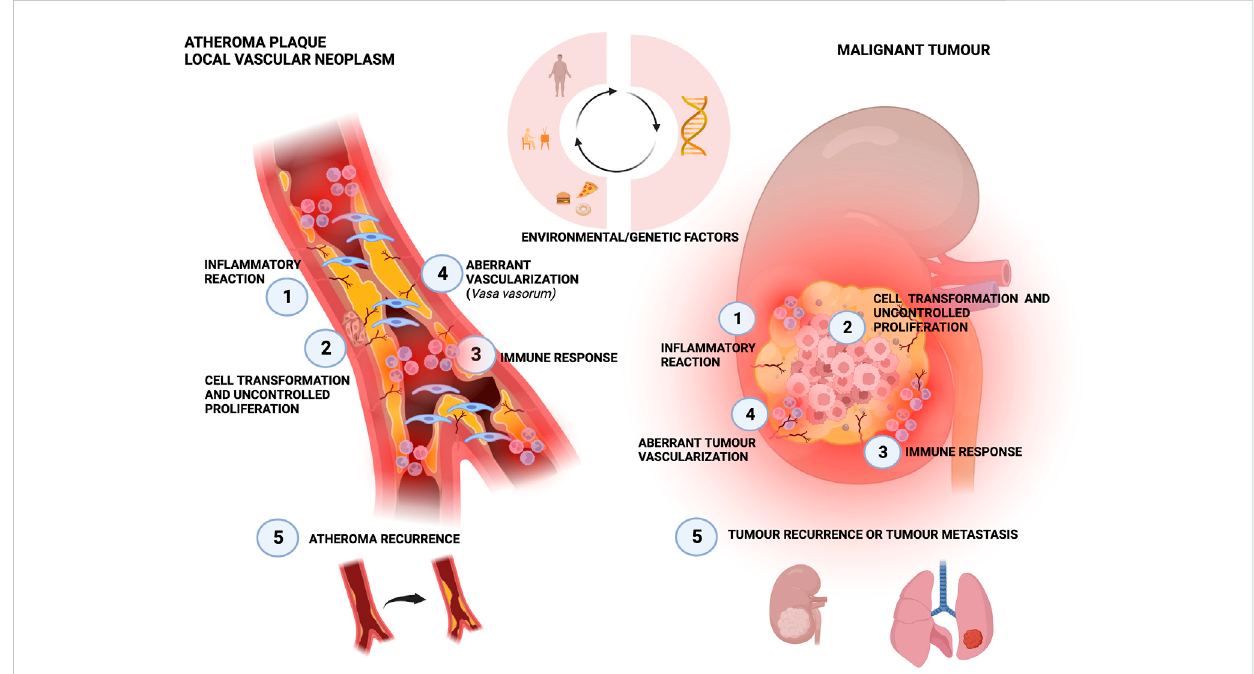
FIGURE 3 Similarities between atherosclerotic plaque and local neoplasia. The three circular arrows show that both diseases can be in fl uencedby these same risk factors. Both processes are initiated by an in fl ammatory reaction (Roth et al., 2017), that leads to cell transformation and uncontrolled proliferation (Kubota et al., 2017), which in turn triggers the immune response (Tappia and Blewett, 2020) and an aberrant vascularization (Libby, 2021a). Finally, recurrence is frequently present for both atheroma and cancer (Herrington et al.,